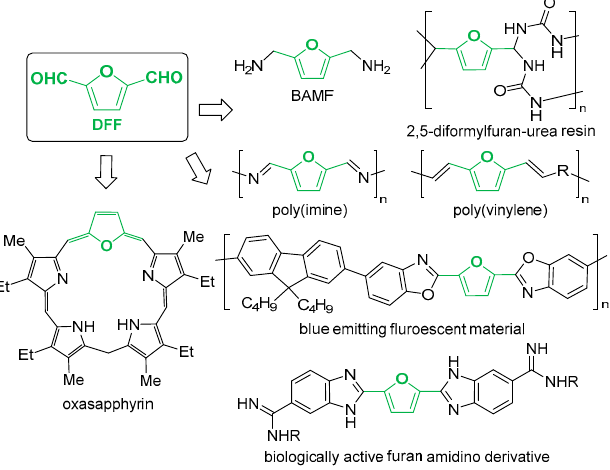
Figure 1. Synthetic and industrial applications of DFF.